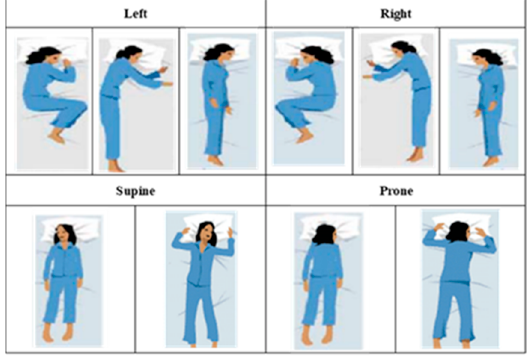
Figure 6. The 10 types of sleep postures [43]. Table 4. The details of the iSP pilot dataset.